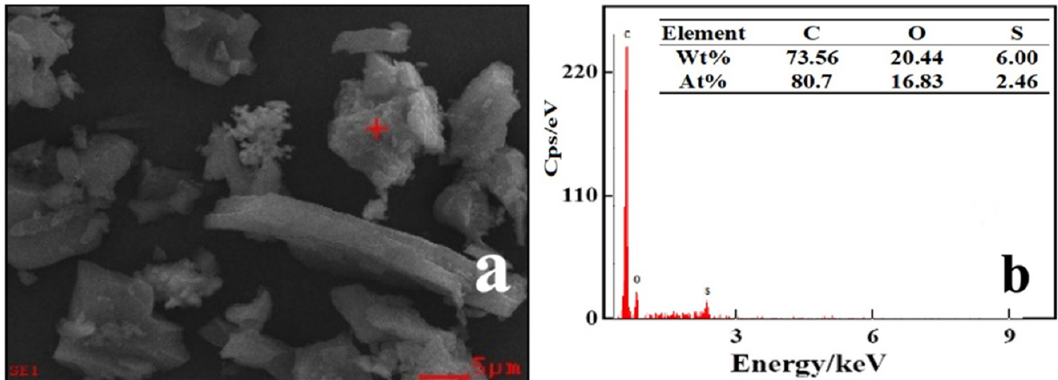
Figure 3. SEM and EDS maps of PACMC after RhB adsorption. ( a ) PACMC-SEM; ( b ) PACMC-EDS.